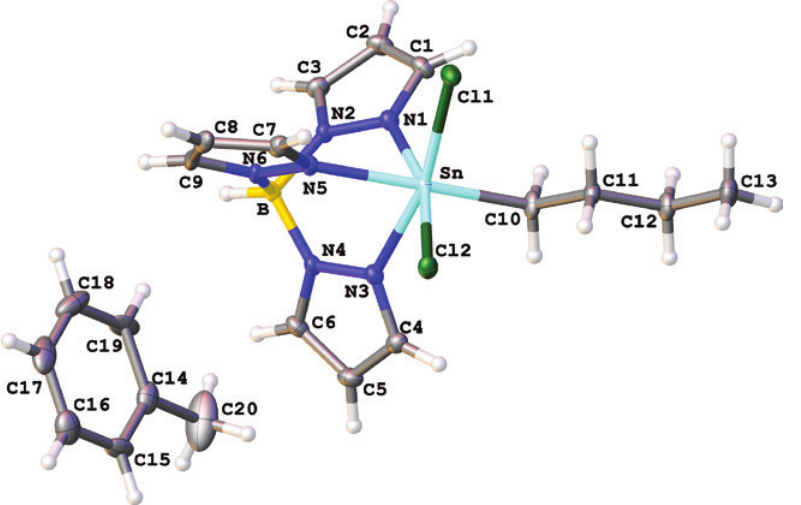
Figure 1: Molecular structure of TpSn(Cl) (Ortep view in